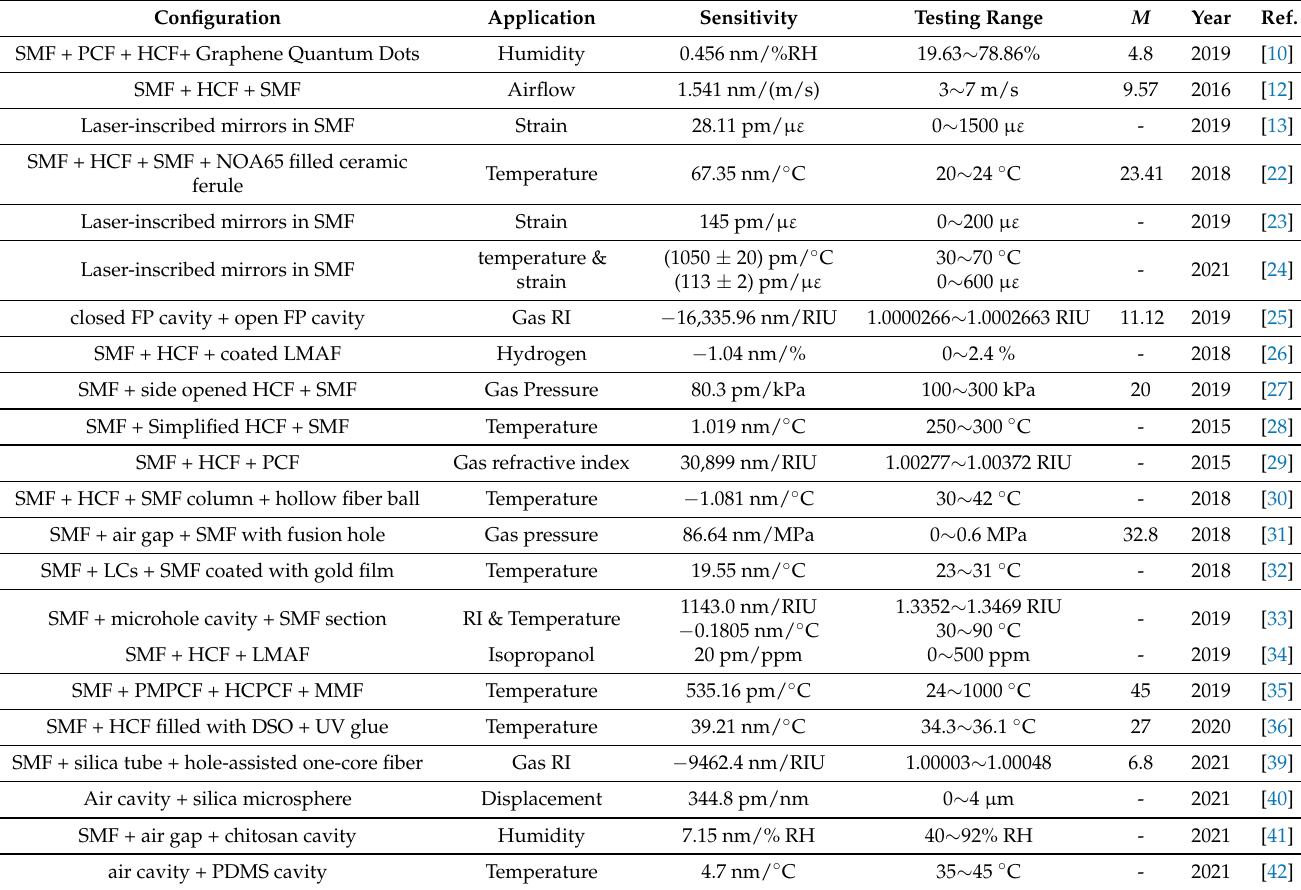
Table 2. Summary of the Cascaded FPI Fiber Sensors with the Vernier